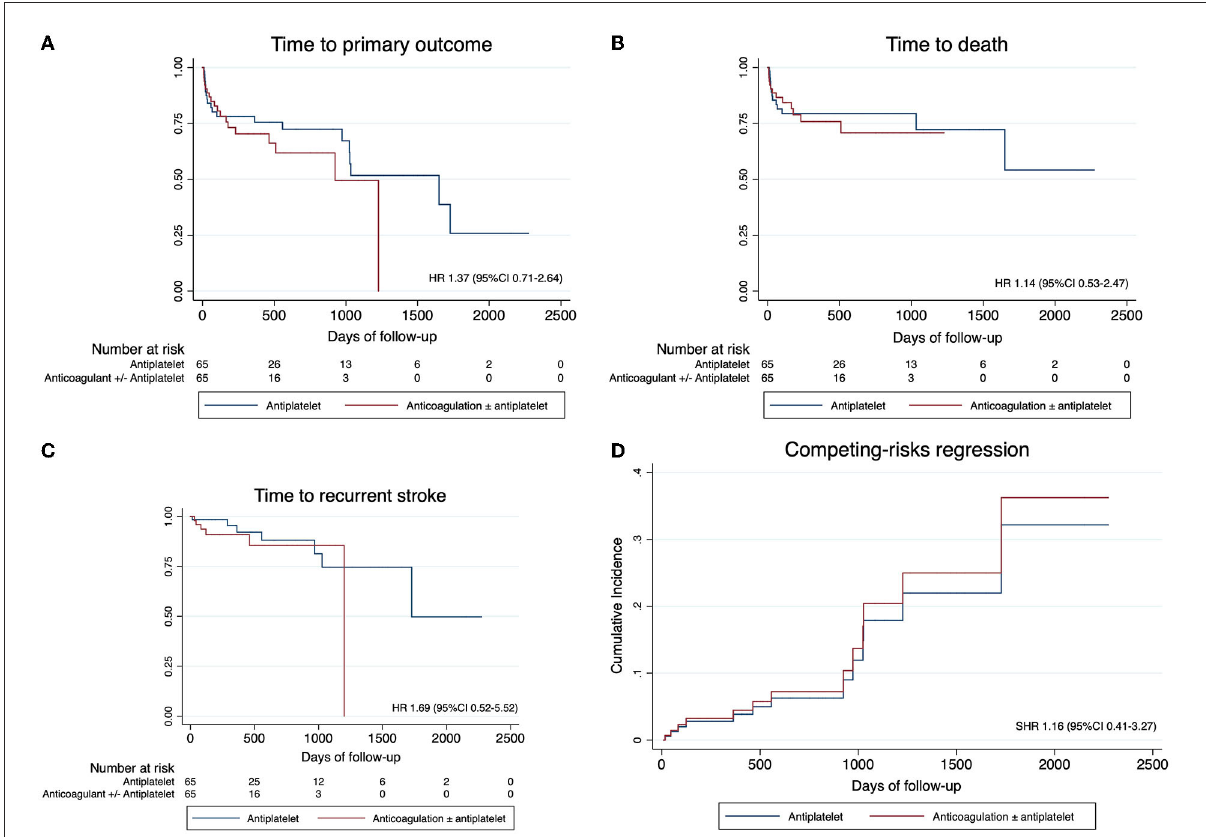
FIGURE2 Survival estimates for the primary and secondary outcomes in the propensity score-matched cohort. Survival estimates for (A) the primary outcome of recurrent stroke, major bleeding event, or death; (B) recurrent stroke; and (C) death due to any cause. (D) The cumulative incidence function of stroke or major bleeding, with death considered as a competing risk. Solid blue lines indicate treatment with antiplatelet, while dashed red lines indicate treatment with anticoagulant ± antiplatelet. HR, hazard ratio; CI, confidence interval; SHR, subhazard ratio. Note that major bleeding events were too few in number; therefore, survival estimates are not